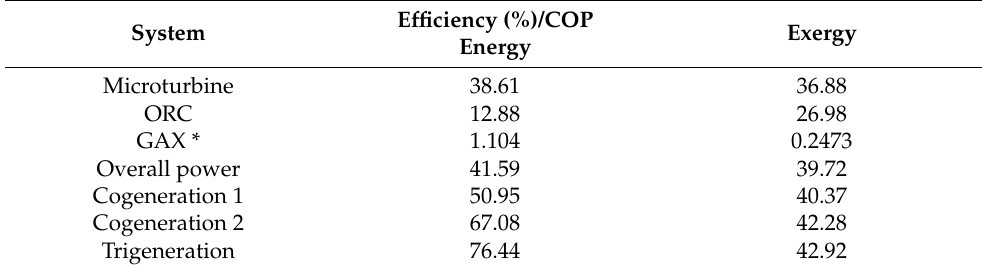
Table 6. Performance results of the multigeneration